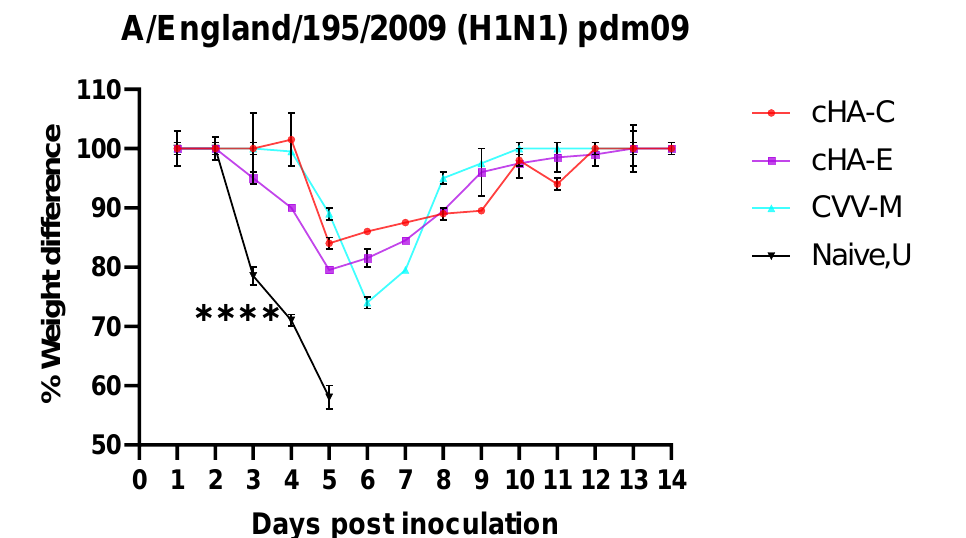
Figure 7. Weight monitoring of mice challenged with the A/England/195/2009. Summary of the weights of mice recorded over a period of 14 days during the influenza virus challenge; mice that were immunized with constructs cHA-C, cHA-E, and CVV-M before the H1N1 isolate (A/England/195/2009 pdm09) challenge, had their weights staying above 30%. The naïve group that received PBS before the challenge begun to lose weight steadily on day three, persisting until all mice euthanized by day five. Percentage weight differences were analysed by one-way ANOVA followed by Dunnett’s multiple comparisons test using the GraphPad prism 8.0.1. p < 0.00005: ****.